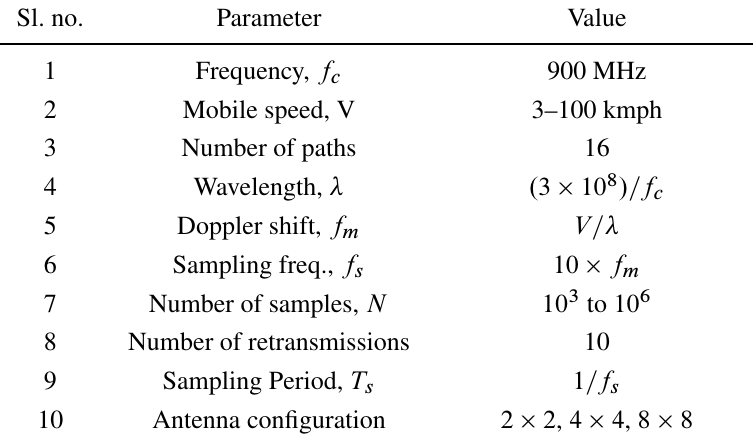
Table 2. Parameters used for simulating channel using Clarke–Gans model. Sl. no.